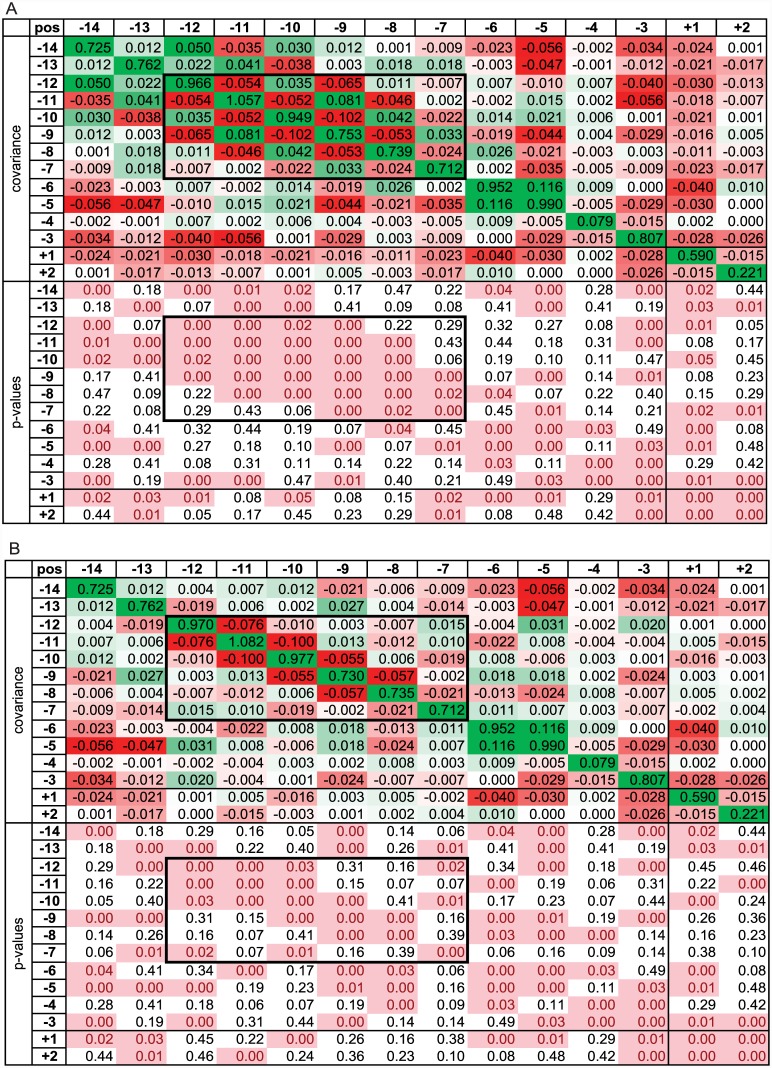
Covariance matrix of strength vectors for constitutive-exon ASSs (M. musculus).Notations are the same as in Fig 2. Positions (-12, -7) demonstrating the characteristic periodic pattern are marked by the black rectangle. (A) Original DSS sequences. (B) Artificial DSS sequences with the same dinucleotide content as the original sequences in positions (-12, -7) (see main text).